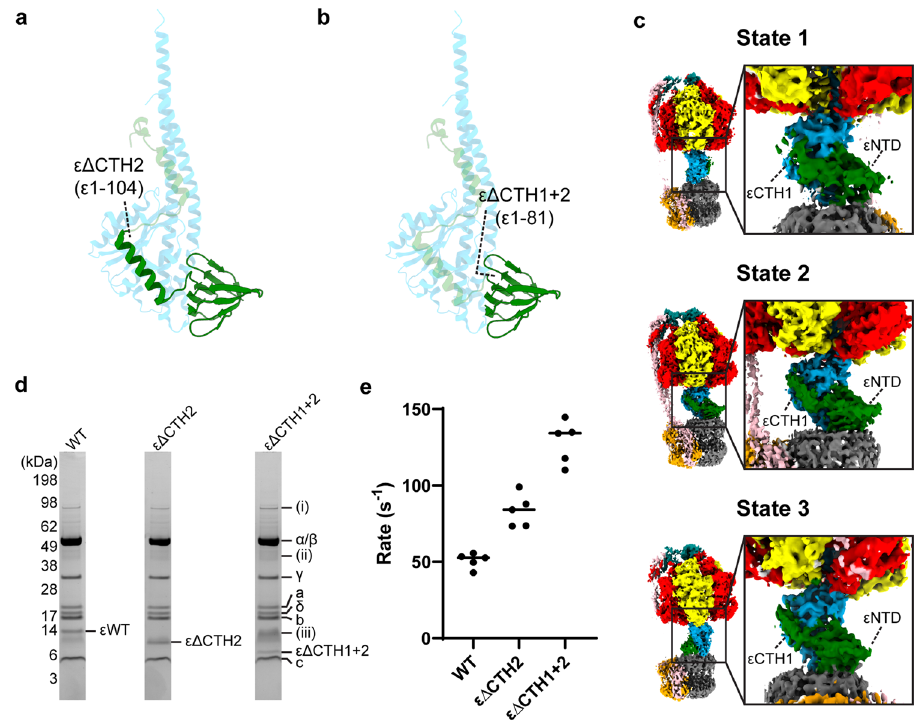
Fig. 7 Subunit ε attenuates ATPase activity. a εΔ CTH2 truncation retains the ε CTH1 which can bind to the γ subunit. b εΔ CTH1 + 2 retains only the ε NTD akin to the ε CTD down conformation. c Cryo-EM maps of the 3 states generated using the εΔ CTH2 truncation mutant after exposure to 10 mM MgATP showed E. coli F 1 F o ATP synthase in the half-up sub-state, with ε CTH1 attached to the subunit γ . The 3 states have been rotated successively by 120° to show the position of subunit ε . d Coomassie stained SDS PAGE (uncropped image provided as Supplementary Data 5) of puri fi ed E. coli F 1 F o ATP synthase WT, εΔ CTH2 and εΔ CTH1 + 2. Subunits labeled and minor contamination bands identi fi ed as; (i) Ribonuclease E, (ii) GroEL, and (iii) ElaB. e ATP regeneration assays of WT (containing full length subunit ε ), εΔ CTH2 ( ε 1 – 104) and εΔ CTH1 + 2 ( ε 1 – 81). All data points and mean are shown (raw traces are in Supplementary Fig. 8 and values in Supplementary Data 6). Removal of ε CTH2 results in higher ATP turnover than WT. Removal of both ε CTH1 and ε CTH2 shows higher ATP turnover than removal of only ε CTH2.